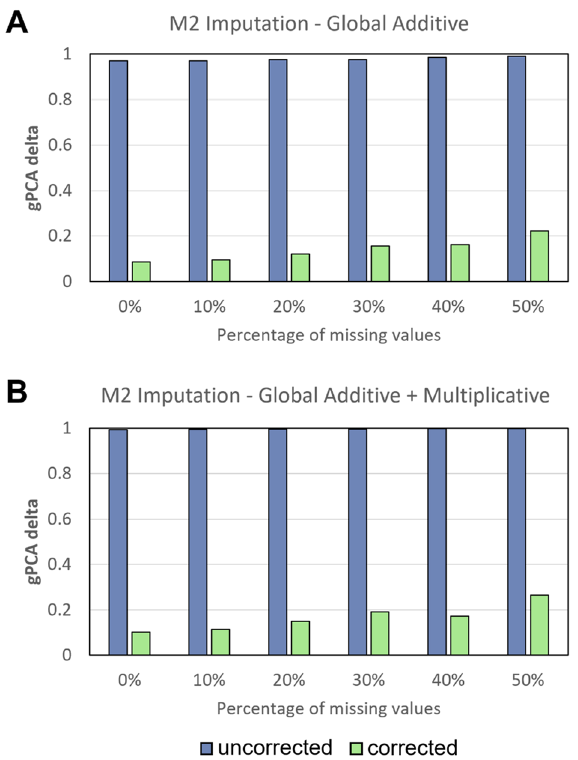
Figure 4. Initial simulation, with varying % of missing values (i.e., 10%, 20%, 30%, 40%, 50%) imputed by M2 only, is used for evaluation of batch correction for M2 based on gPCA delta. Only ComBat is used as BECA for this evaluation. gPCA delta results for both ( A ) additive only and ( B ) mixed batch effects (Additive + Multiplicative) scenarios showed that after batch correction, remnant batch in M2 is attenuated given lower % missing